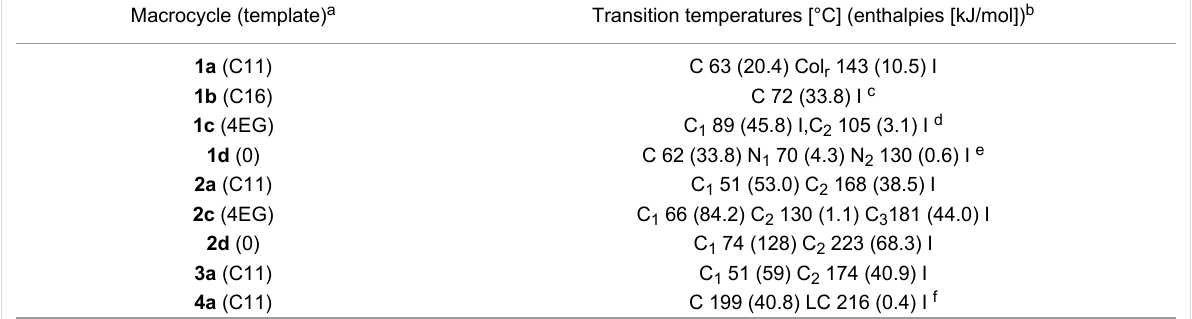
Table 1: Phase transitions and corresponding enthalpies of the discussed